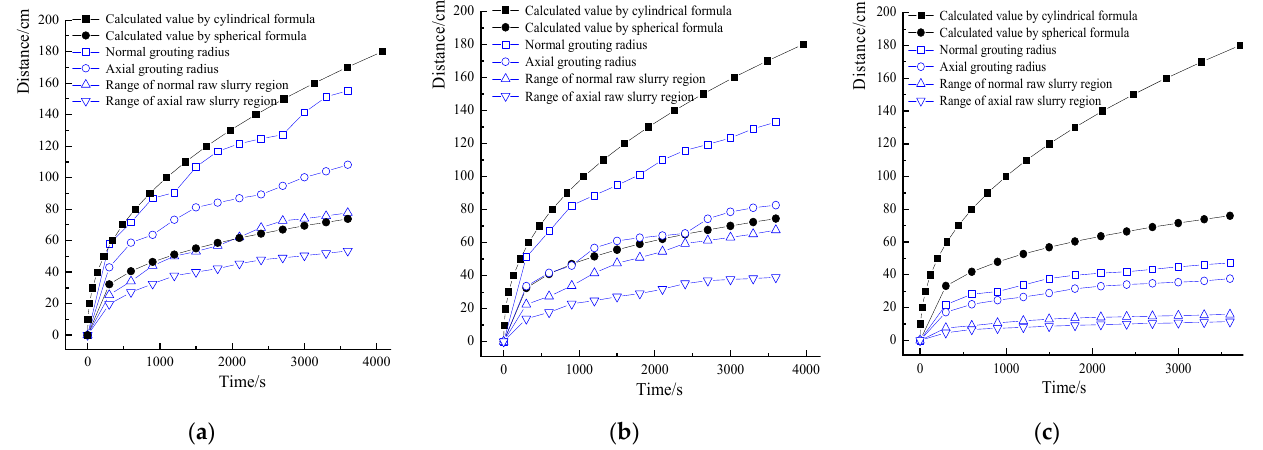
Figure 6. Comparison between numerically simulated values and theoretically calculated values of grouting radius at distinct water–cement ratios; ( a ) w:c = 1.0; ( b ) w:c = 0.8; ( c ) w:c = 0.6